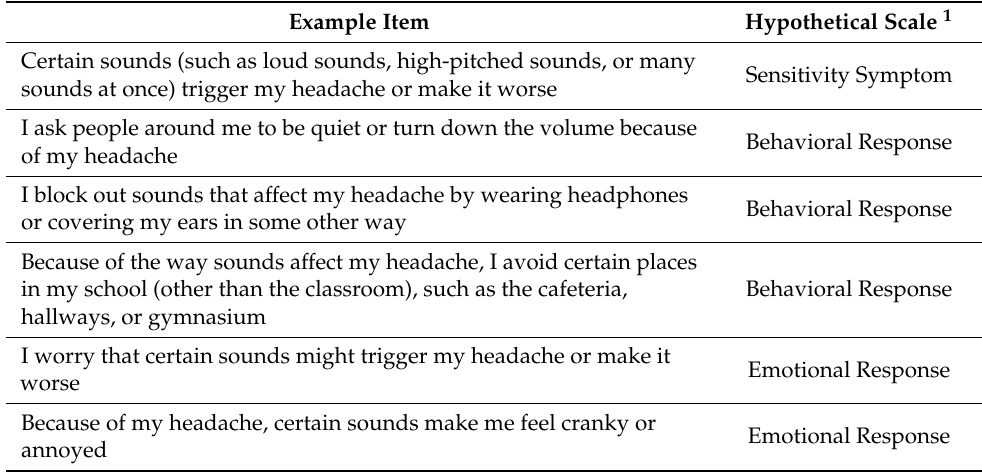
Table 2. Subset of items for proposed inclusion in the